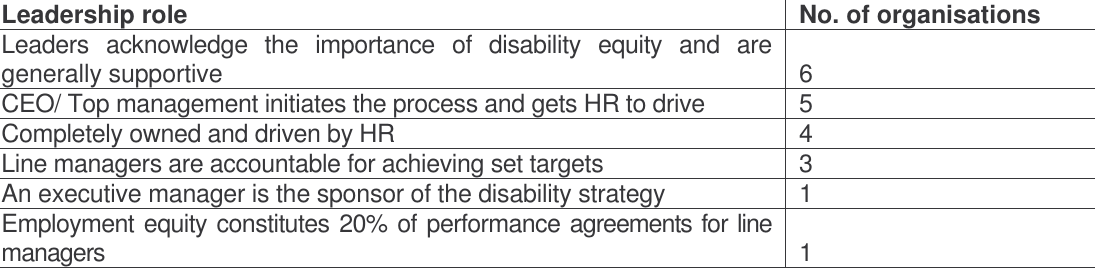
Table 3: Role of senior management Leadership